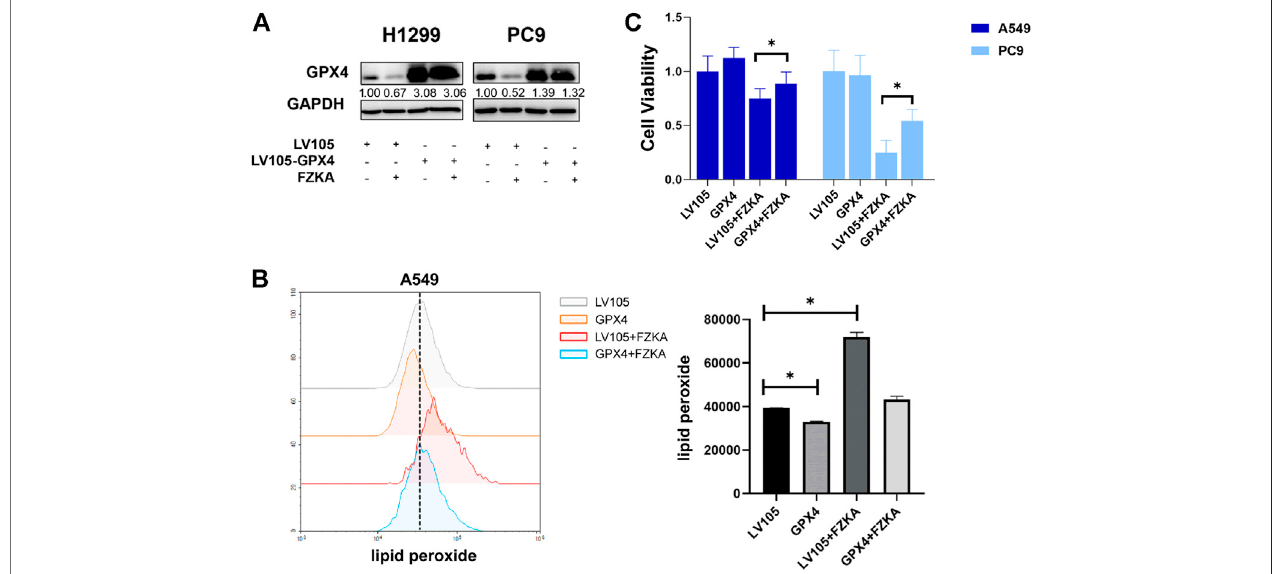
FIGURE 6 | Overexpression of GPX4 reversed the ef fi cacy of FZKA. (A) , Cultured H1299 and PC9 cells were transfected with negative control and GPX4 lentiviral vectors,thentreatedwithorwithoutFZKAfor24 h.Theexpression ofGPX4wasdetected bywesternblot. (B) ,lipidperoxidationassaywasperformedinA549cellafter treatment with FZKA or/and GPX4 lentivirus. (C) , Cells were transfected and treated with FZKA, and CCK-8 assay were then conducted. Each point represents the mean ± SEM, n = 3. * p <